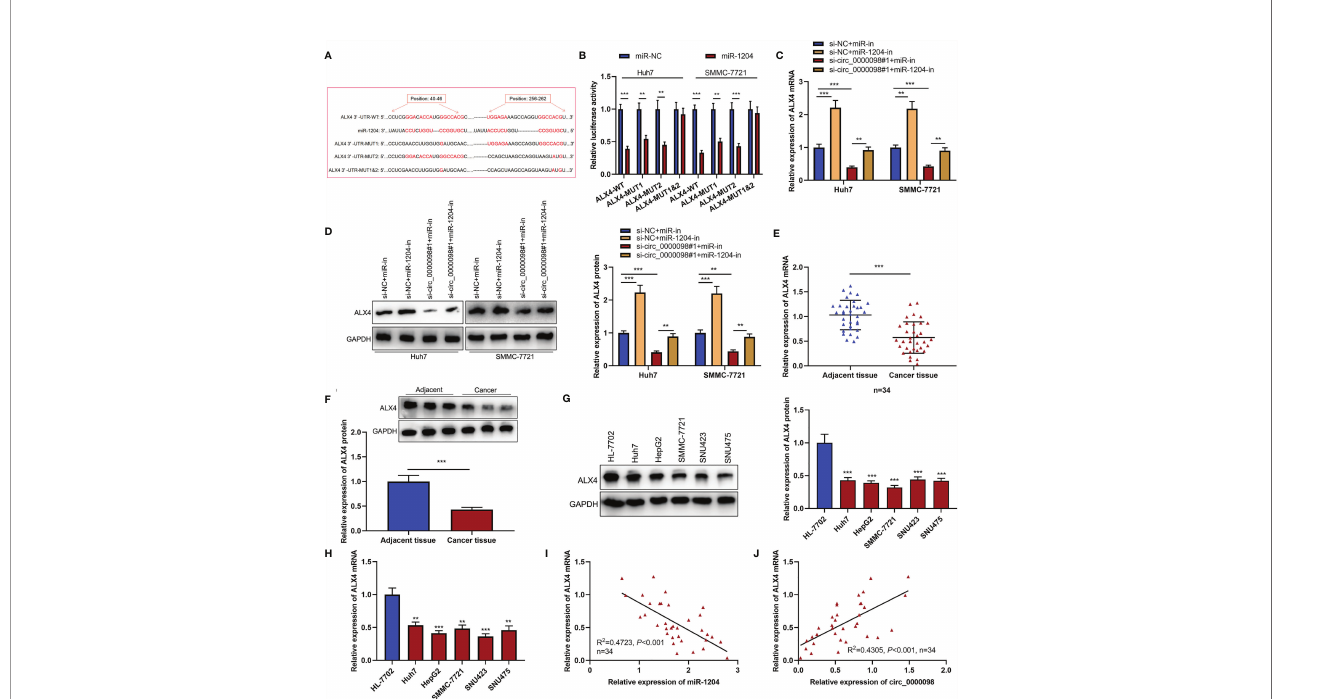
FIGURE 5 | Circ_0000098 promoted the expression of ALX4 by sponging miR-1204. (A) The binding sequence between miR-1204 and ALX4 was predicted by TargetScan tool (http://www.targetscan.org/). (B) The binding relationship between miR-1204 and ALX4 was detected by dual-luciferase reporter assay. (C, D) qRT- PCR and Western blot were used to detect the effects of circ_0000098 and miR-1204 on ALX4 expression in Huh7 and SMMC-7721 cells. (E-H) qRT-PCR and Western blot were used to detect the expressions of ALX4 mRNA and protein in HCC tissues and cells. (I, J) Pearson ’ s correlation analysis was used to analyze the correlation between ALX4 mRNA and miR-1204 or circ_0000098 expressions in 34 HCC tissues. ** P < 0.01 and *** P < 0.001.